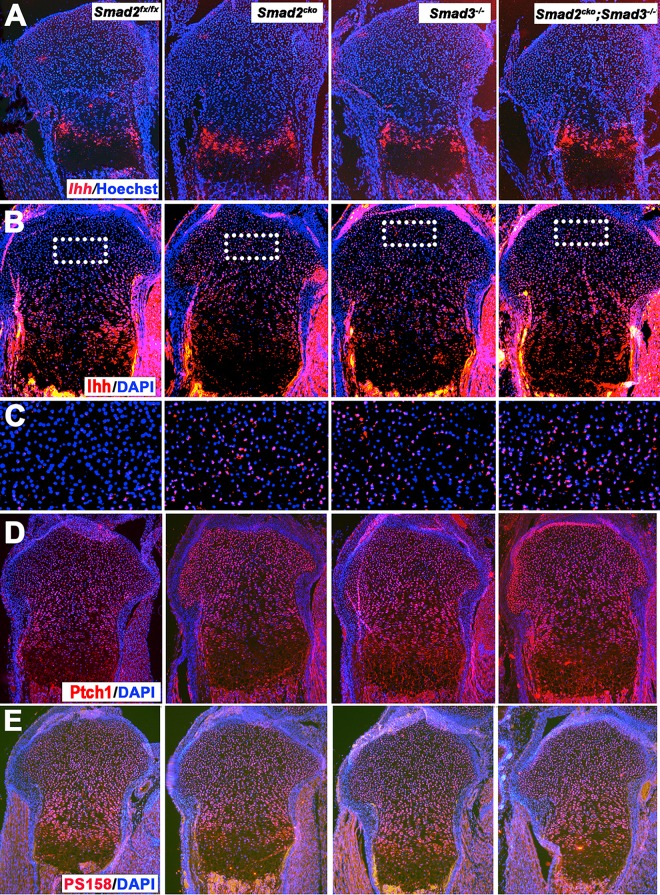
Increased Ihh mRNA and protein levels and activity in Smad2 and Smad3 mutant growth plates.All images are P0 proximal tibias (A) RNA in situ hybridization for Ihh showing increased expression in Smad2CKO, Smad3-/-, and double mutant growth plates. (B) Immunostaining for Ihh protein showing diffusion into the resting zones of Smad2CKO, Smad3-/-, and double mutant growth plates. (C) Magnifications of the boxed regions in (B). (D) Immunostaining for Ptch1, showing increased protein levels throughout the growth plate in mutants, particularly in the resting zone. (E) Immunostaining for phospho-Smad1/5/8 (PS158) protein showing no significant difference in levels of activated BMP signaling comparing Smad2CKO, Smad3-/-, or double mutant to control Smad2fx/fx growth plates. Smad2CKO = Smad2fx/fx;Col2a1Cre.